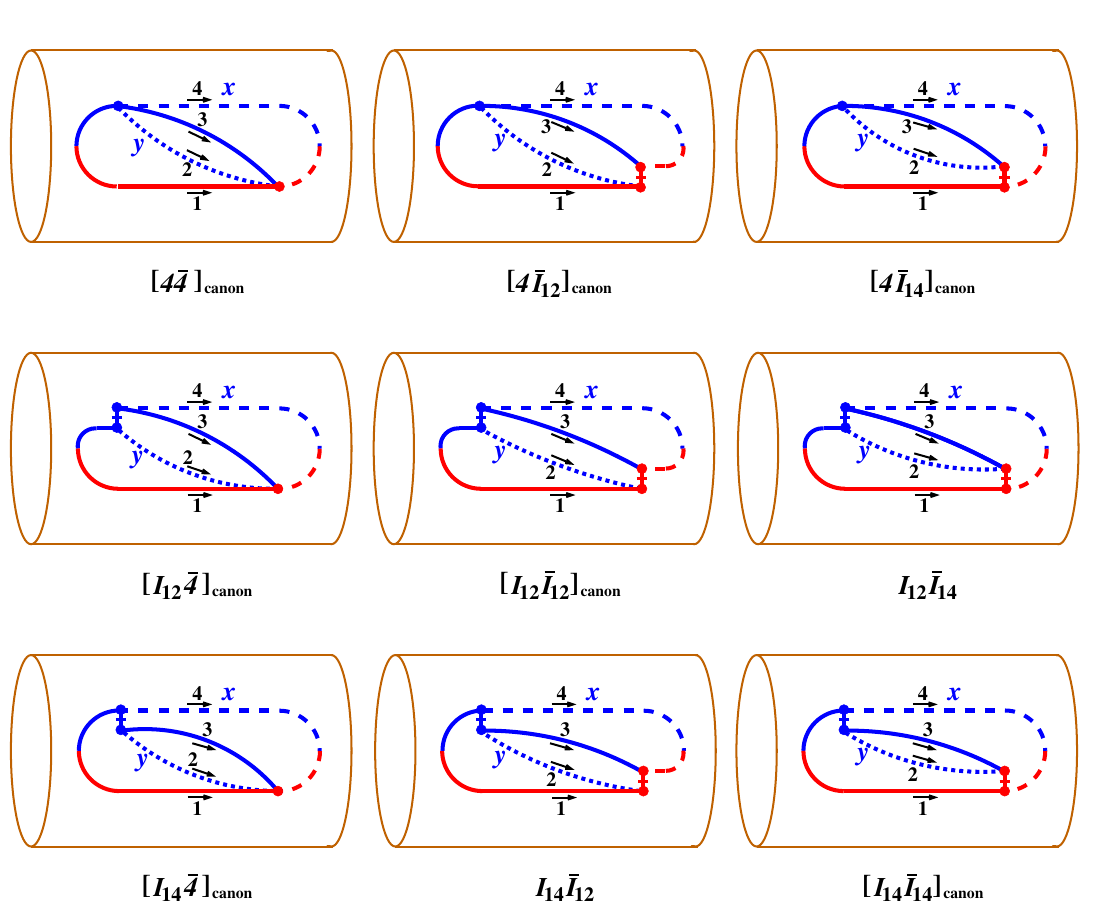
Figure 14 . Like the middle diagram of figure 13 but here also including all instantaneous diagrams that contribute to the canonical routing (1234) and so to [ d Γ /dx dy ] canon